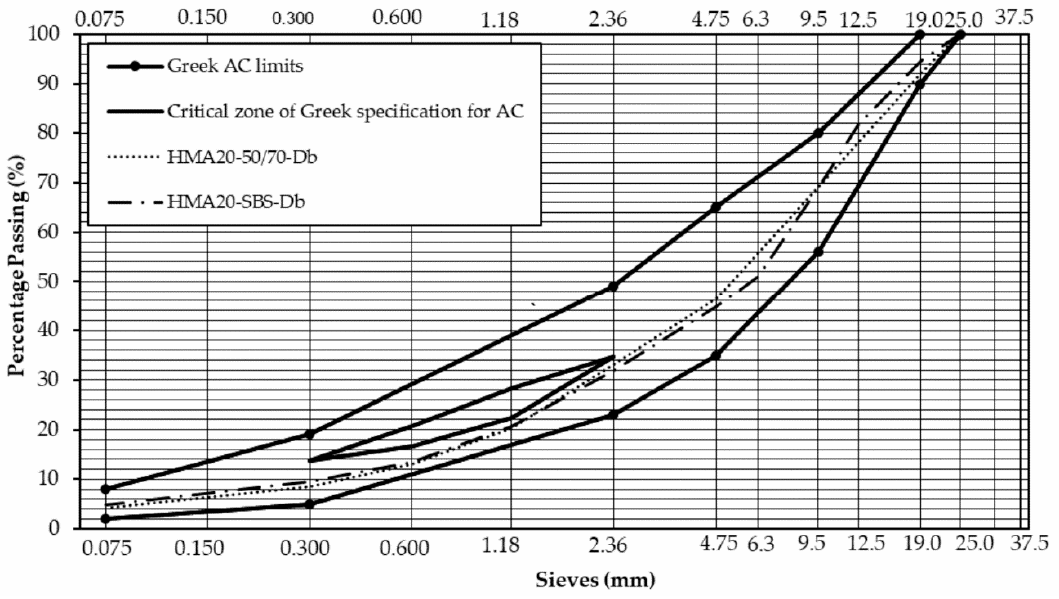
Figure 5. Grading curves of HMA20-50/70-Db and HMA20-SBS-Db.